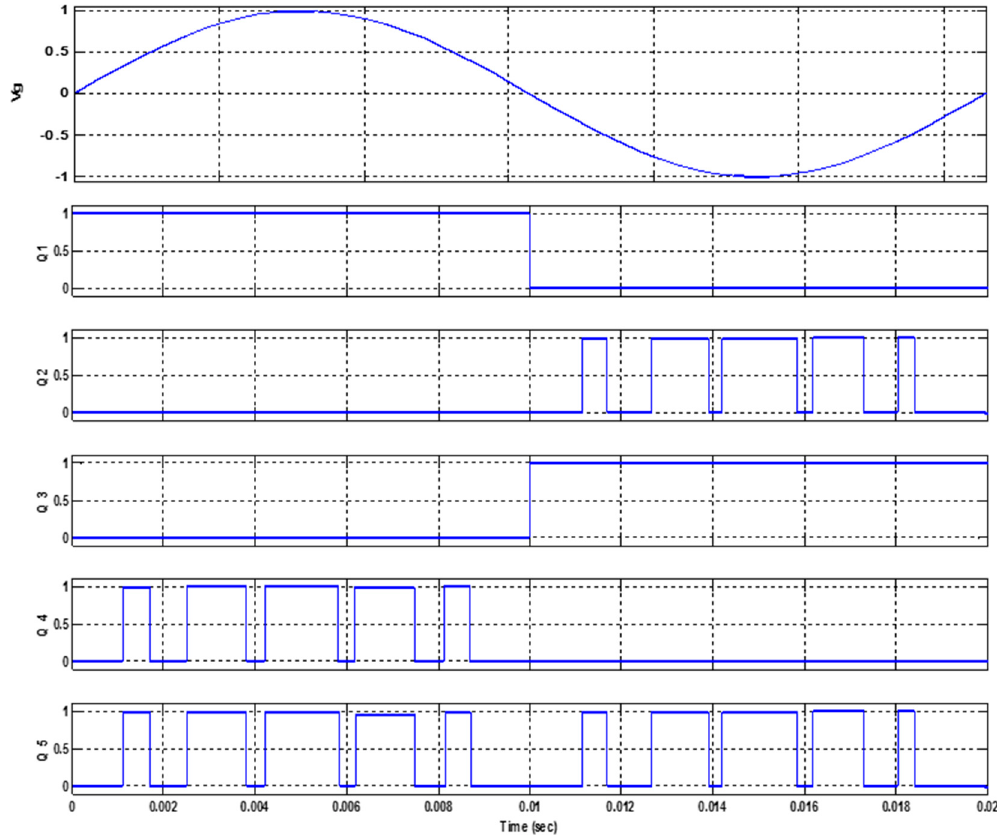
Figure 2. Control signals of H5 inverter switches.